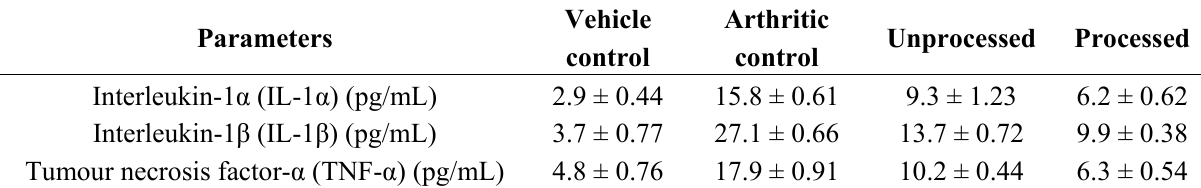
Table 3. Effects of processed and unprocessed GTW on inflammatory mediators in Freund’s Complete Adjuvant (FCA)-induced arthritic rats a